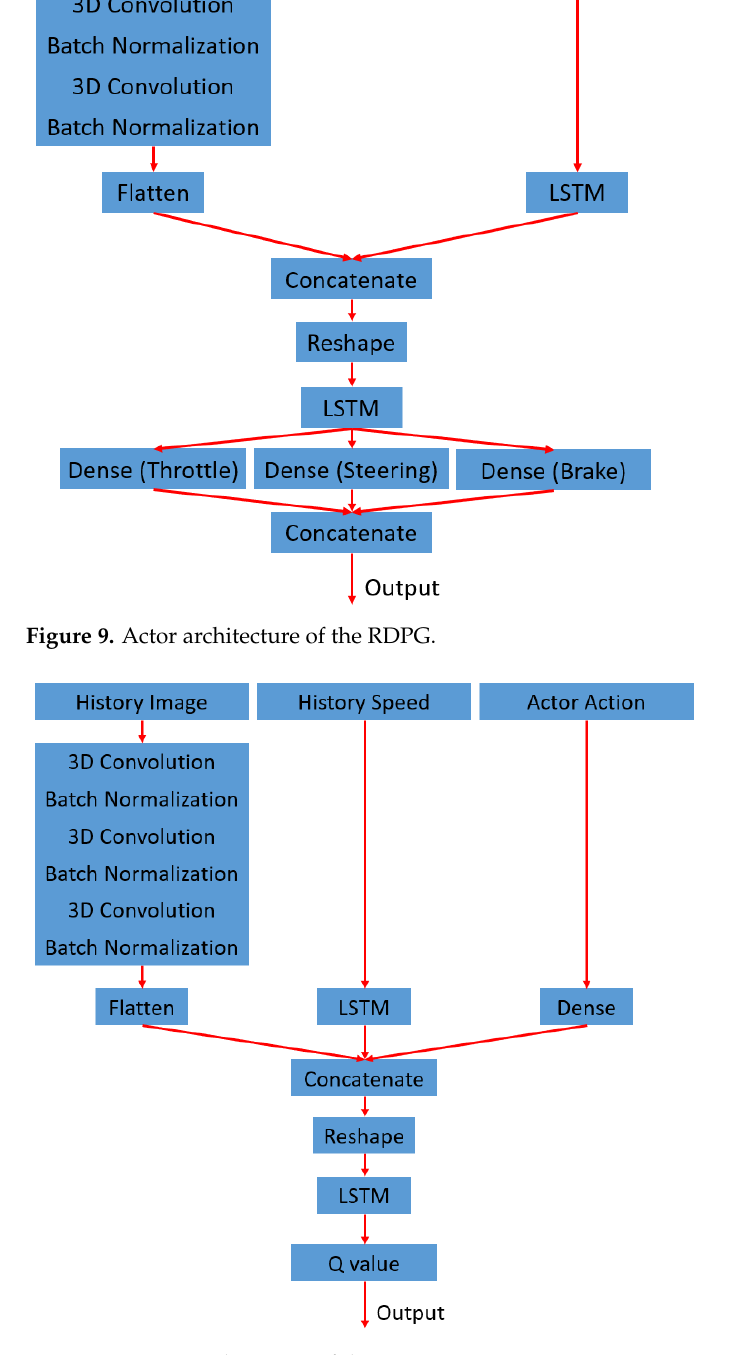
Figure 10. Critic architecture of the